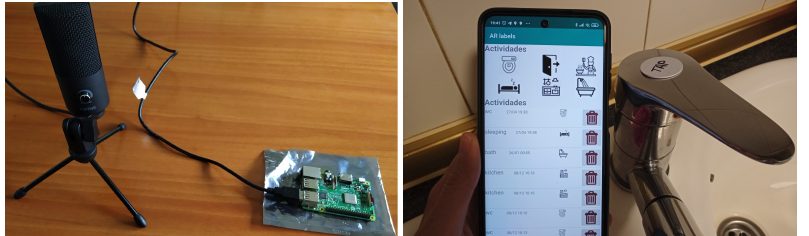
Figure 1. ( Left ) Raspberry Pi B+ with USB microphone which sets up the IoT device for collecting and recognizing ambient sound events; ( Right ) mobile application for labelling of events together with NFC tag to facilitate data collection and